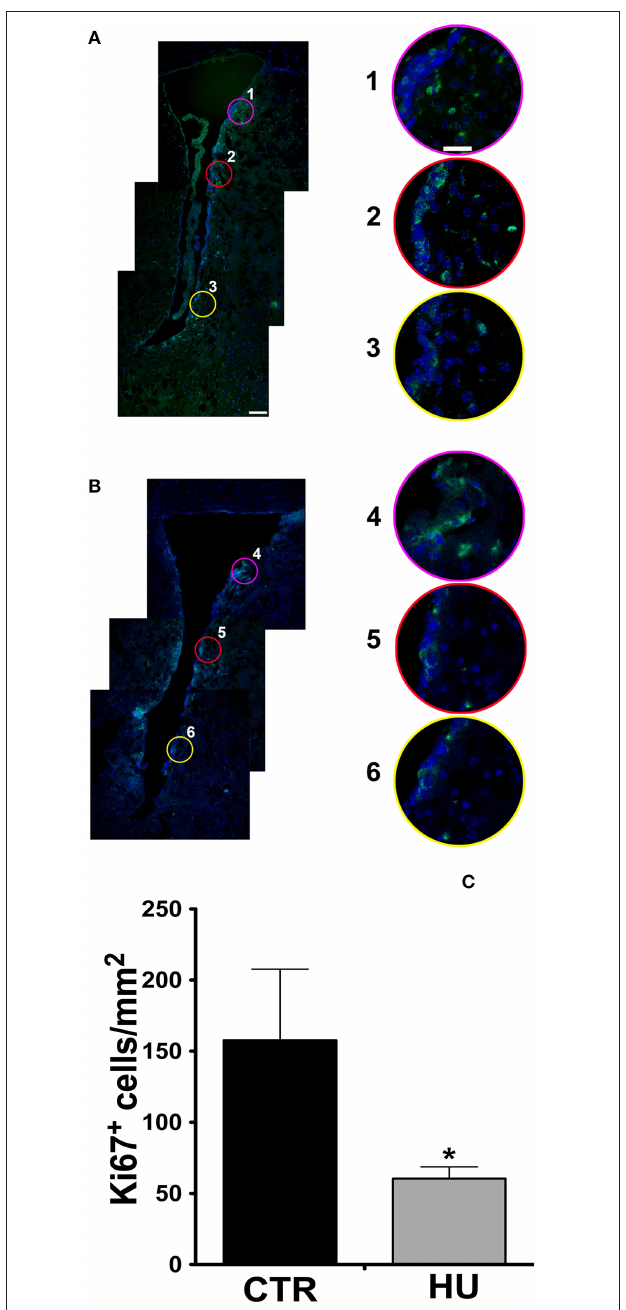
FIGURE 1 | Confocal analysis of 10 µ m coronal sections at the bregma level. Staining for Ki67 (Alexa 488 Goat anti-rabbit antibody), nuclei are stained with DAPI in blue (A) CTR mouse SVZ (1, 2, 3 are enlargements of the upper, medium and lower region of the SVZ) (B) HU mouse SVZ (4, 5, 6 are enlargements of the upper, medium and lower region of the SVZ). The border in pink, red and yellow of the enlargements corresponds with the circle indicated in the lower magnification figure (A,B) . (C) The number of Ki67 positive cells per mm 2 in the area described in material and methods. Values represent means ± SEM. We analyzed the statistical differences with the one-tailed unpaired t -test p < 0.0365. Significance symbols: * p < 0.0365. Scale bar 100 µ m in A is also representative for B ; scale bar 25 µ m in 1 is representative of enlargement 2, 3, 4, 5, and 6).